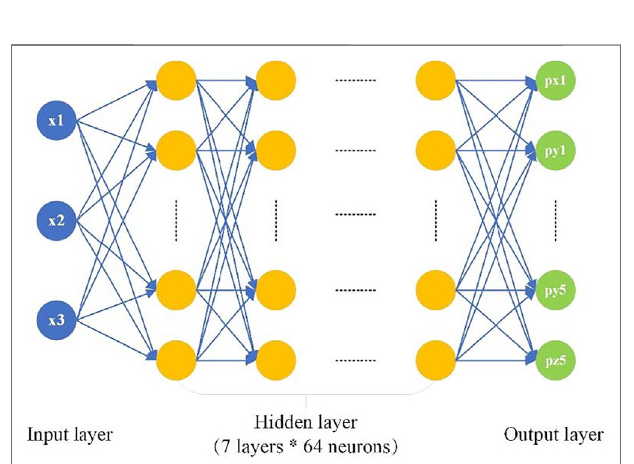
FIGURE 3 | Image processing of the posture of the soft arm.